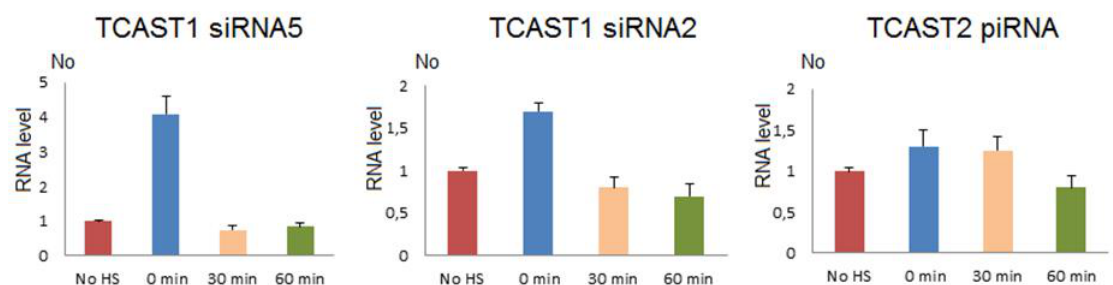
Figure 4. The dynamics of expression of TCAST1 siRNAs 5 and 2, and of TCAST2 piRNA in T. castaneum adults under standard conditions (no HS), immediately after 24 h of heat stress at 40 °C (0 min), at 30 min and 60 min of recovery, respectively. Expression is shown in relative term, No values, which are obtained by dividing each No value by No value of control (no HS). Columns show the average of two different RT-qPCR experiments performed in triplicate and error bars represent standard deviations.